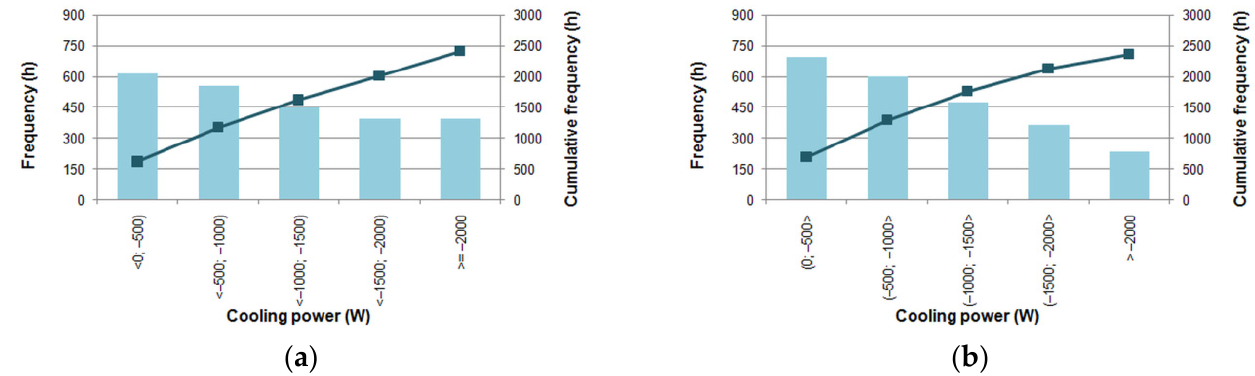
Figure 19. Histograms of cooling power: ( a ) the base case; ( b ) method 1.